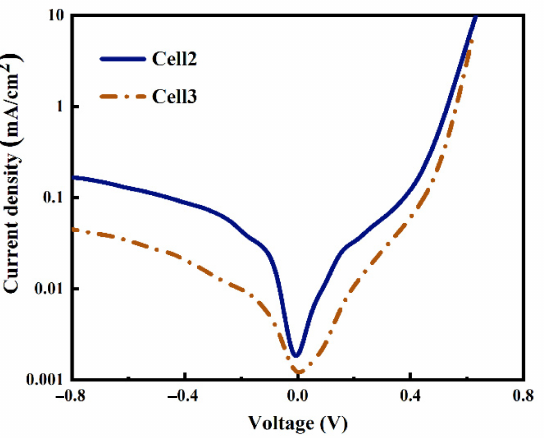
Figure 11. Dark J-V curves of the two cells using firing-through Al paste with and without adding silicon